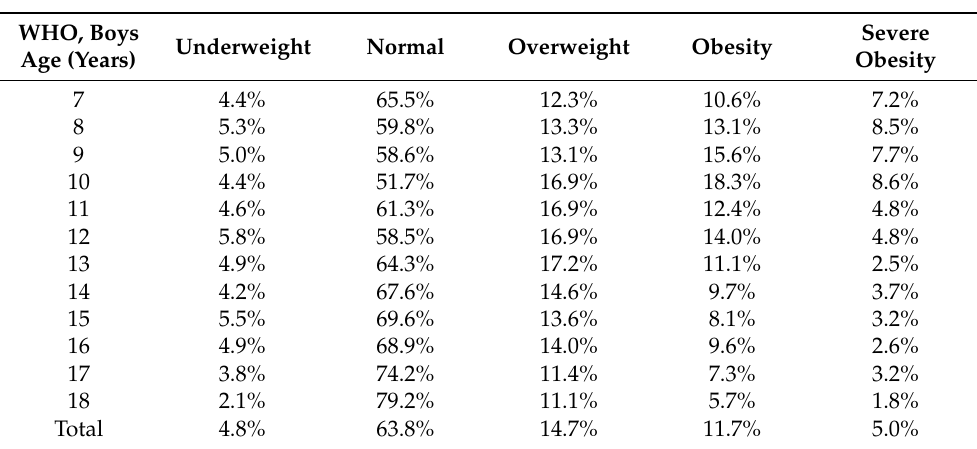
Table 3. Underweight, overweight and obesity prevalence in boys, according to age, using WHO percentile reference.